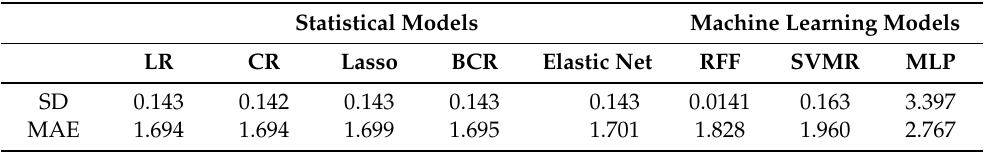
Table 4. Comparative middle lane table of different learning methods results (speed) used. The error metric is the mean absolute error and is expressed in km/h.